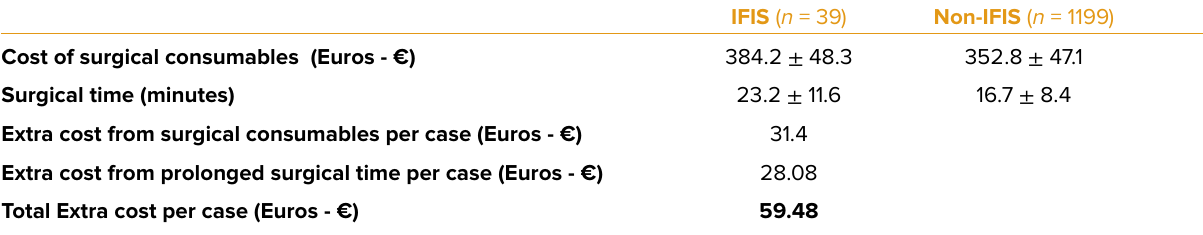
Table 2. Average cost of surgical consumables and surgical duration in uneventful cataract surgeries along with respective comparison between cases with or without